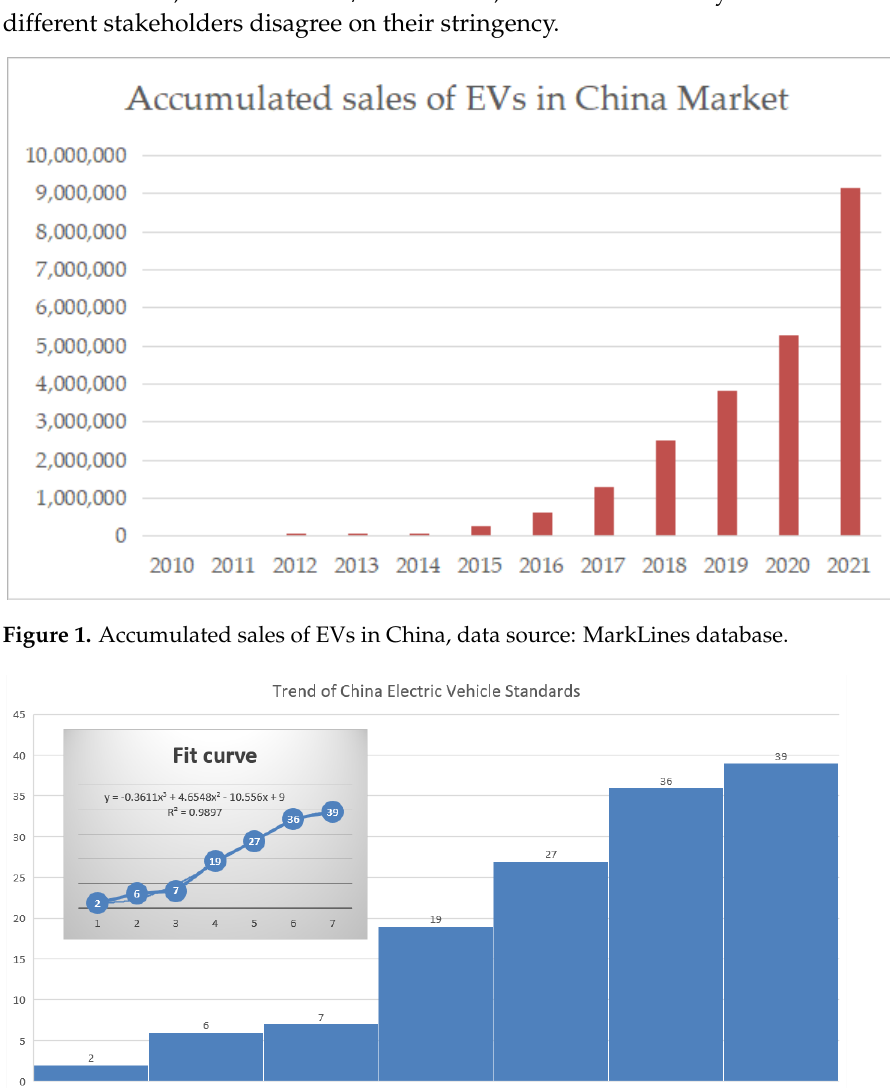
Figure 2. The published trend of China electric vehicle standards.